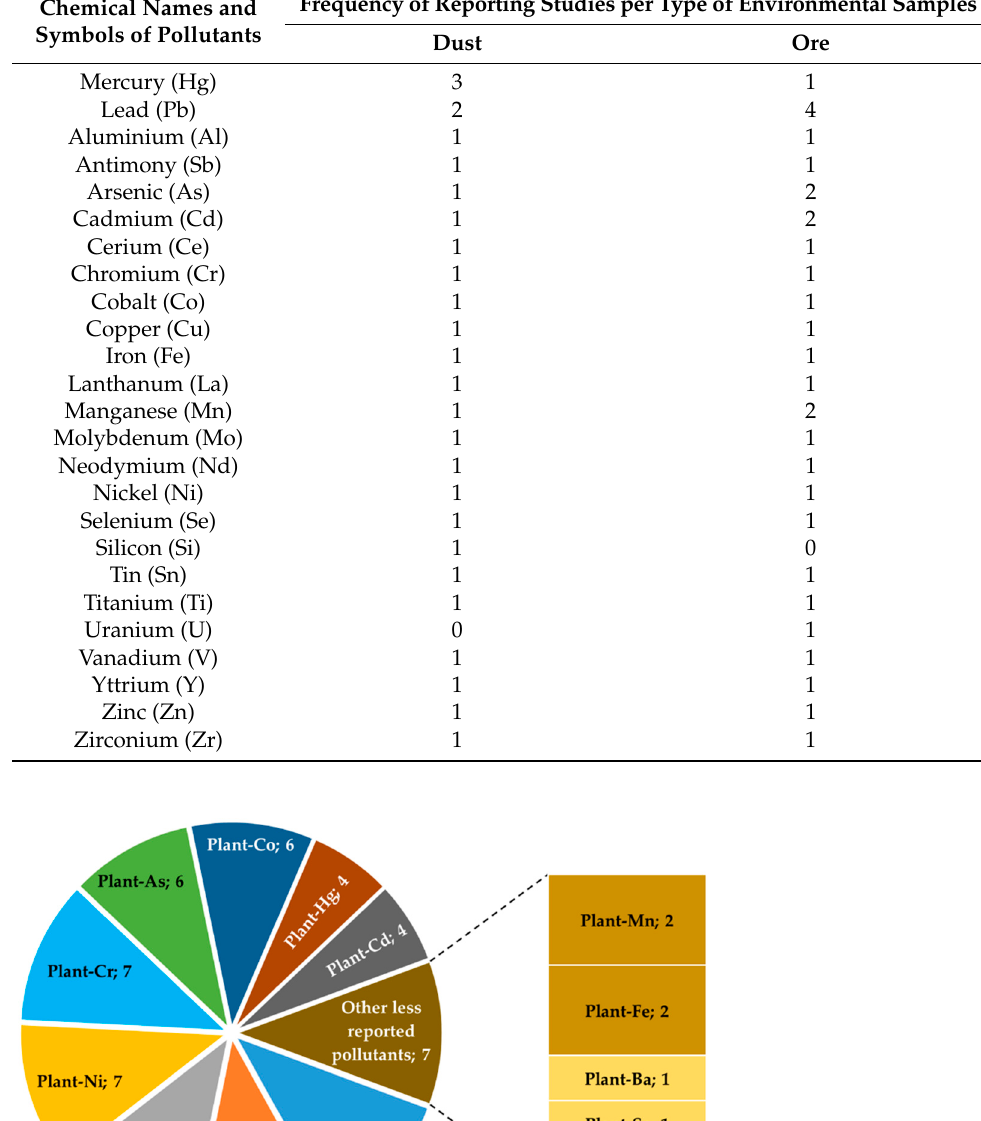
Table A3. Type and frequency of reported pollutants in ore and dust samples. Twenty-four environmental pollutants were reported in each sample (ore; n = 7 and dust; n = 7). In dust samples, most pollutants were reported in one study [31] . Frequencies are given for pollutants reported in up to four studies, each.